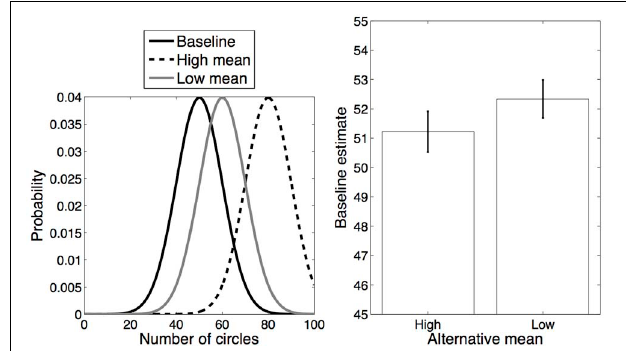
FIGURE 5 | Experiment 3 design and results. Left : Distributions for each category. Right : Average estimates for the baseline category in each condition. Error bars represent standard error of the